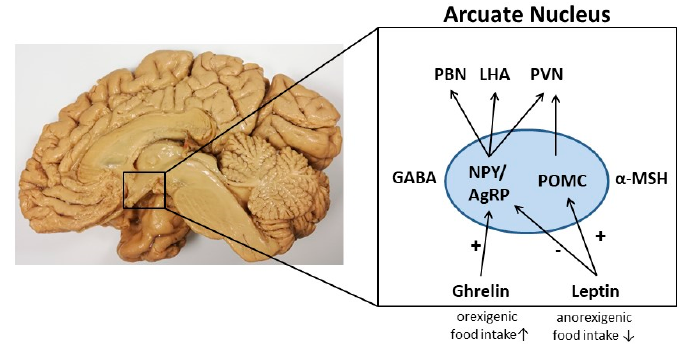
Figure 1. A schematic illustration of the control of food intake in the arcuate nucleus (ARC) of the hypothalamus. In this nucleus, two subpopulations of neurons, the orexigenic NPY/AgRP neurons, and anorexigenic POMC neurons, regulate the process of food intake. These neurons communicate with other hypothalamus nuclei such as the paraventricular nucleus (PVN), the lateral hypothalamic area (LHA), and the parabrachial nucleus (PBN). As metabolic hormone leptin can signal to the ARC by inhibiting NPY/AgRP neurons leading to reduced food intake. Furthermore, leptin activates POMC neurons resulting in decreased food intake. In contrast, ghrelin stimulates NPY/AgRP neurons and signals to orexigenic pathways. GABA, gamma-aminobutyric acid; MSH, melanocyte-stimulating hormone.